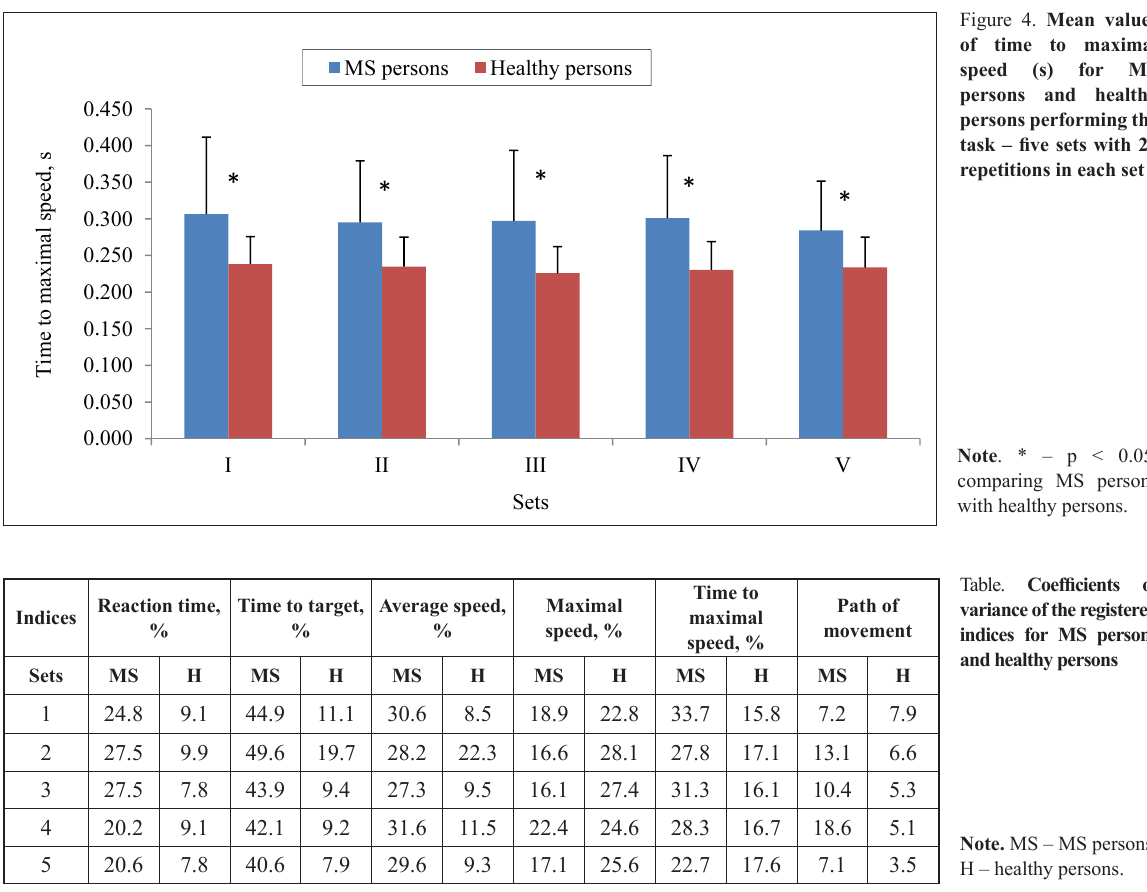
Figure 4. Mean values of time to maximal speed (s) for MS persons and healthy persons performing the task – five sets with 20 repetitions in each set